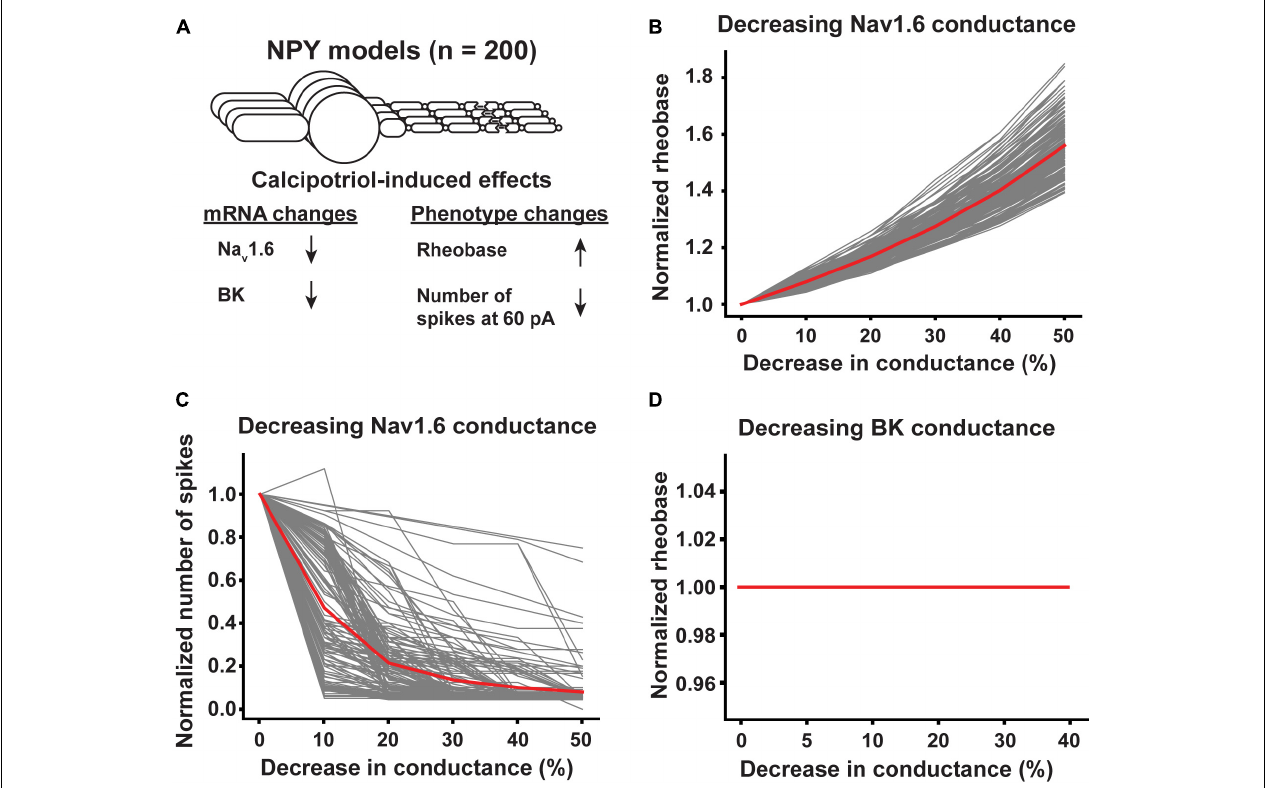
FIGURE 7 | Effect of calcipotriol-induced changes in ion channel expression on the excitability of NPY + neurons. (A) Calcipotriol-induced effects on NPY + neurons. (B) Effect of decreasing Nav1.6 conductance on NPY + model neuron rheobases. (C) Effect of decreasing Nav1.6 conductance on NPY + model neuron numbers of spikes generated in response to 60 pA current injection. (D) Effect of decreasing BK conductance on NPY + model neuron